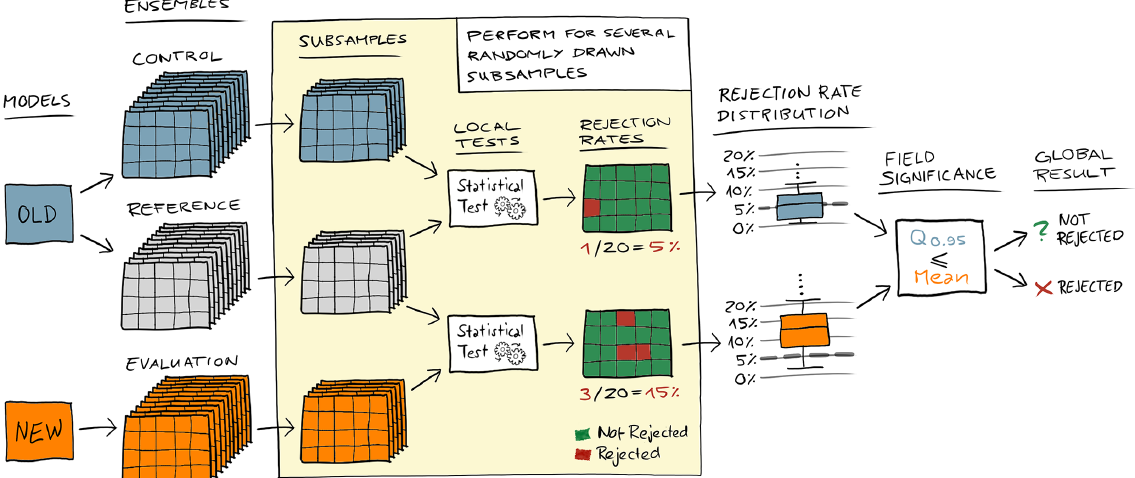
Figure 1. Schematic sketch of the verification methodology. The control and the reference ensembles come from the same “old” model, whereas the evaluation ensemble comes from a “new” model, and we do not know whether this new model is indistinguishable from the model that created the control and reference ensembles. We draw many random subsamples from all three ensembles, perform the local statistical hypothesis tests of the control and evaluation subsamples against the reference subsamples, and then calculate the rejection rate for each subsample. This results in distributions of rejection rates for the control and evaluation ensembles that can be compared to each other in order to decide whether the evaluation ensemble is different. In this work, we reject the global null hypothesis if the mean of the evaluation ensemble rejection rate distribution is equal to or above the 0.95 quantile of the rejection rate distribution for the control